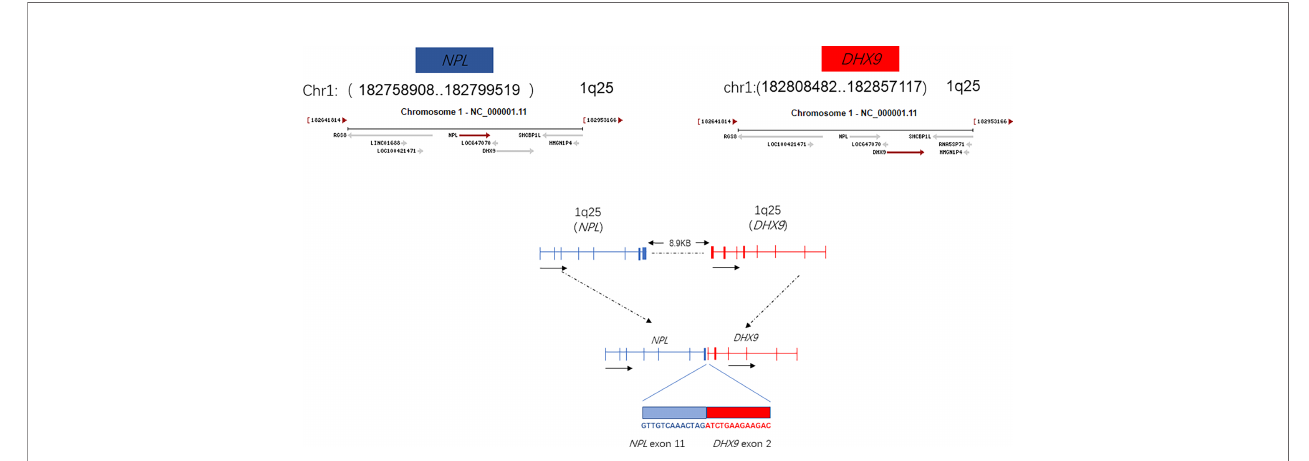
FIGURE 5 | Fusion gene NPL-DHX9 rearrangement through an RNA-sequencing